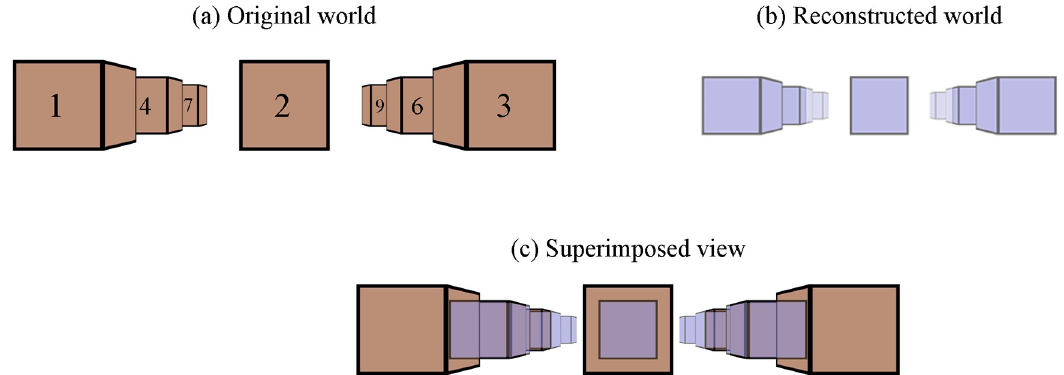
Fig 5. The sample scene from the perspective of the cyclopean eye. The same arrangement as in Fig 3, cubes 1–9 are arranged to be on an equally 1 m spaced rectilinear grid (3 × 3 in xz plane). The edges of the cubes are 40 cm . (a) Brown cubes are in the original world. (b) Blue cubes are the geometric distortion example (Fig 4b) in the reconstructed world corresponding to the brown cubes. The blue cubes 4-6 are on the screen at 3 m distance. (c) Superimposed view of the original world and reconstructed world. In subsequence figures, the superimposed views are presented to aid the visualization of distortions.